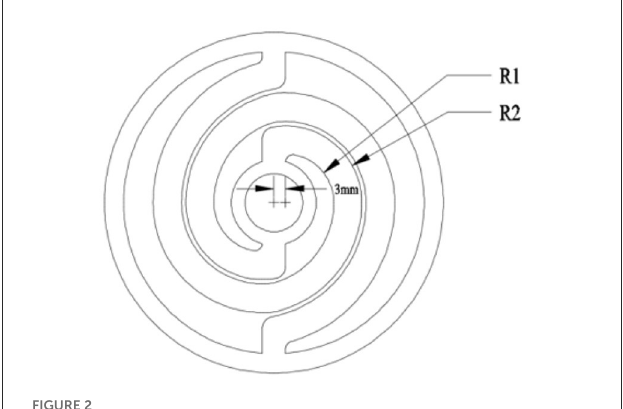
FIGURE2 Symmetric dual-spiral flexible coupler.